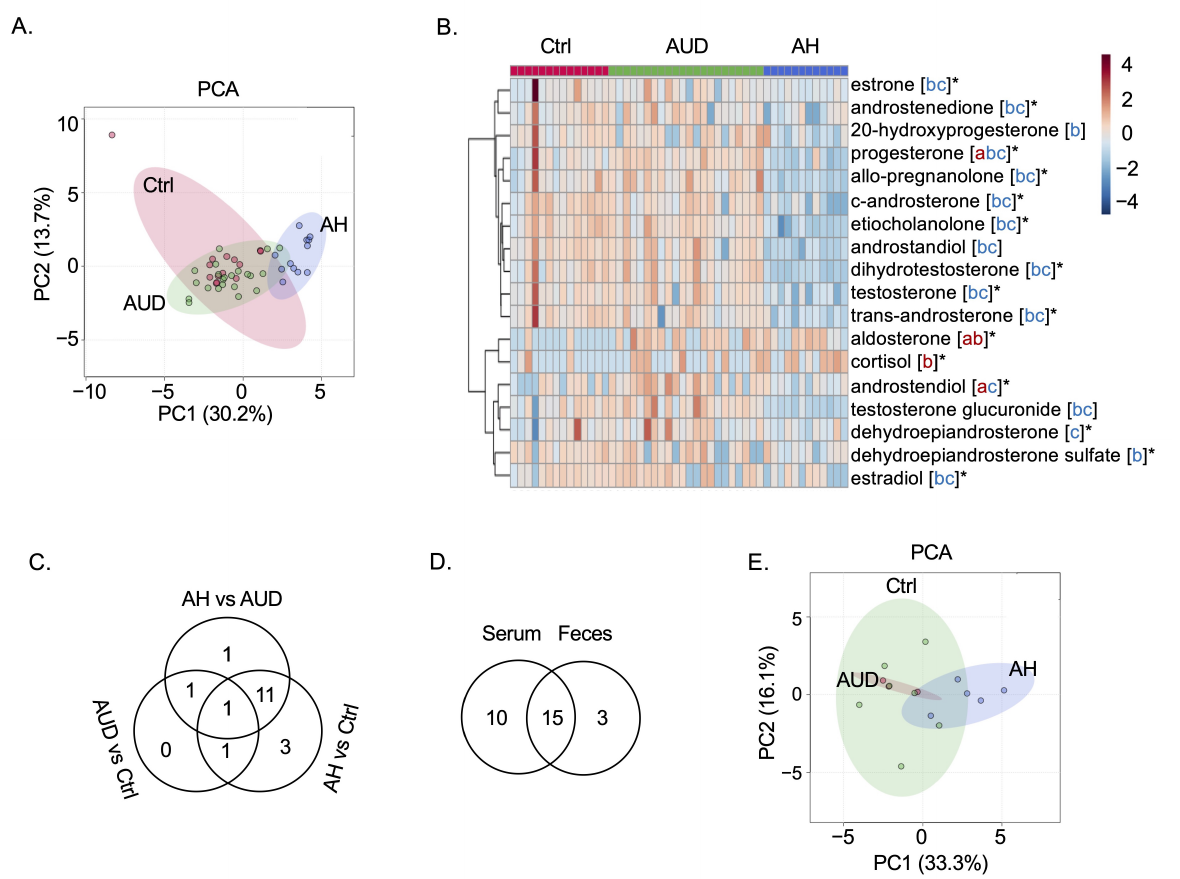
Figure 2. Fecal steroid hormones in male and female patients. ( A ) Principal component analysis (PCA) of fecal steroid hormones in male patients. ( B ) Heatmap of significant fecal steroid hormones in male patients. * FDR < 0.05 in both serum and fecal samples; a: Patients with alcohol use disorder (AUD) vs. control subjects (Ctrl) FDR < 0.05, red: increase in patients with alcohol use disorder; b: Patients with alcohol-associated hepatitis (AH) vs. control subjects FDR < 0.05, red: increase in patients with alcohol-associated hepatitis, blue: decrease in patients with alcohol-associated hepatitis; c: Patients with alcohol-associated hepatitis vs. patients with alcohol use disorder FDR < 0.05, blue: decrease in patients with alcohol-associated hepatitis. ( C ) Venn diagram of significant (FDR < 0.05) fecal steroid hormones in male patients. ( D ) Venn diagram of significant (FDR < 0.05) steroid hormones in both serum and fecal samples. ( E ) Principal component analysis of fecal steroid hormones in female